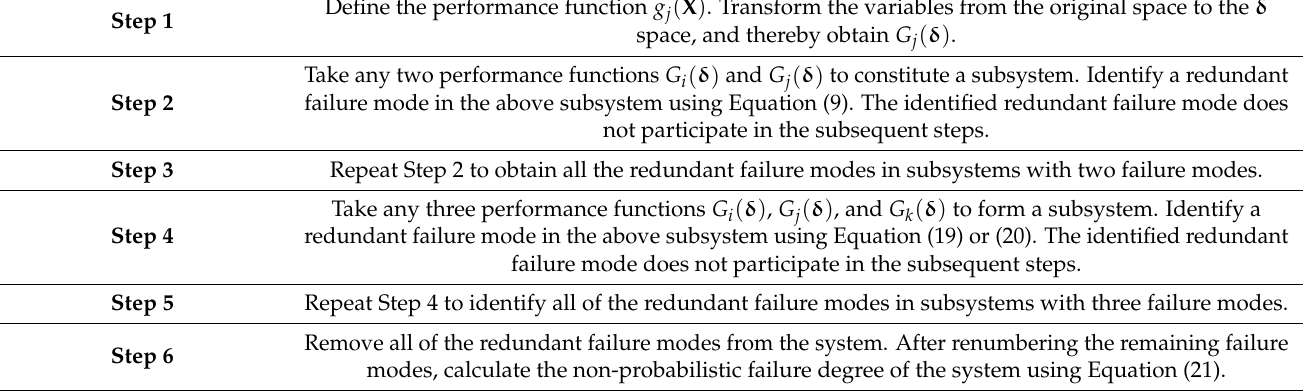
Table 1. Implementation steps of the proposed